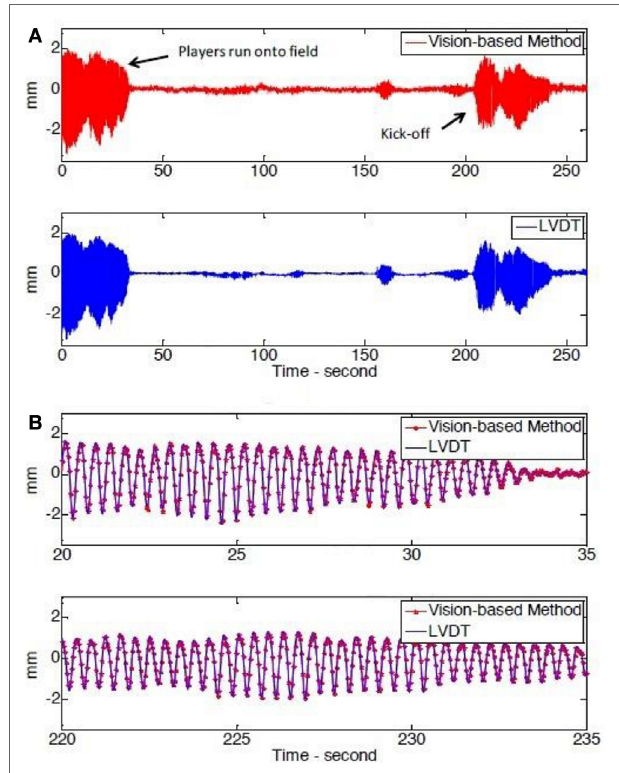
FiGURe 14 | (A) test three displacement datasets and (B) two zoom—in windows from test 3. Reprinted from (Khuc and Catbas, 2016) with permission from John Wiley & Sons, Inc.